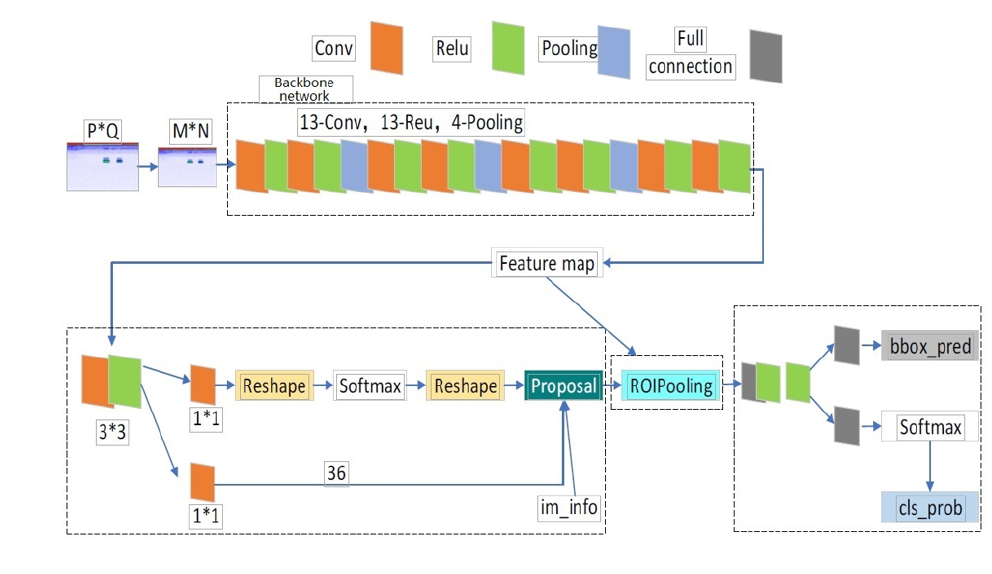
Figure 1. The structure of Faster RCNN.